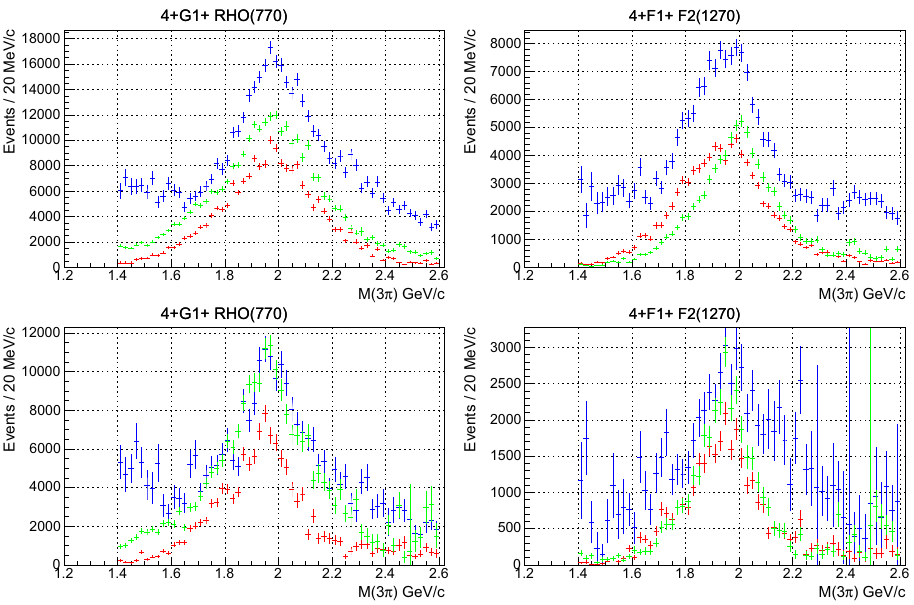
Figure 4. Intensities of waves a) 4 + G 1 + ρ (770) π , b) 4 + F 1 + f 2 (1270) π for the system π + 2 π − ; c), d) the same for the system π − 2 π